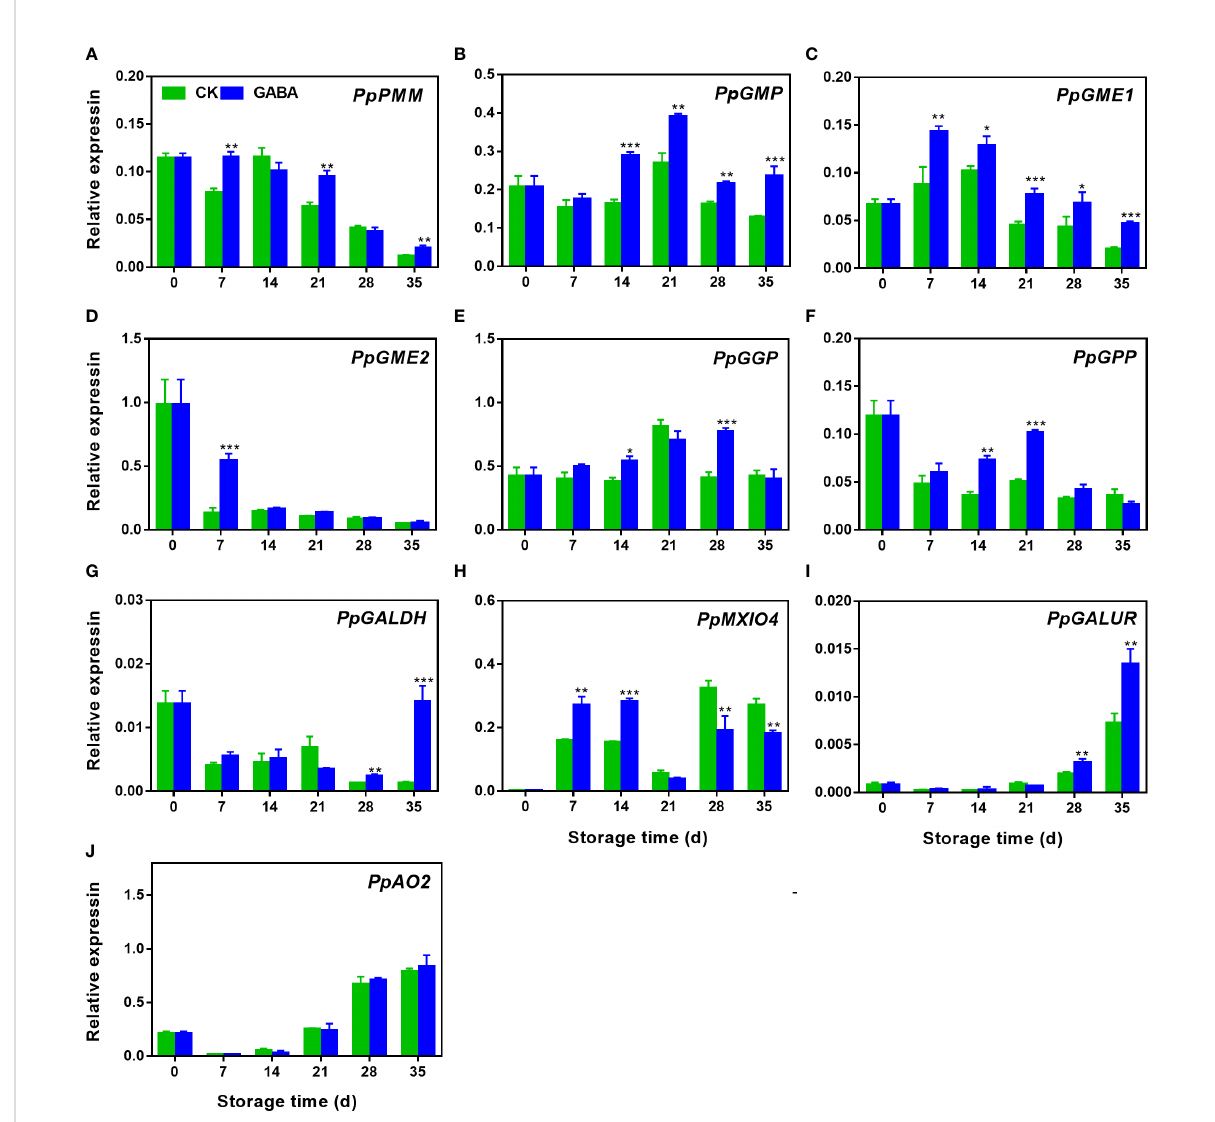
FIGURE 4 Effect of GABA treatment on expression of genes involved in AsA biosynthesis of peach stored at 4°C. Expression levels of PpPMM (A) , PpGMP (B) , PpGME1 (C) , PpGME2 (D) , PpGGP (E) , PpGPP (F) , PpGALDR (G) , PpGALUR (H) , PpMXIO4 (I) and PpAO2 (J) were analysed. Asterisks indicate signi fi cant differences between CK and GABA treatment (*p < 0.05, **p < 0.01, and ***p <